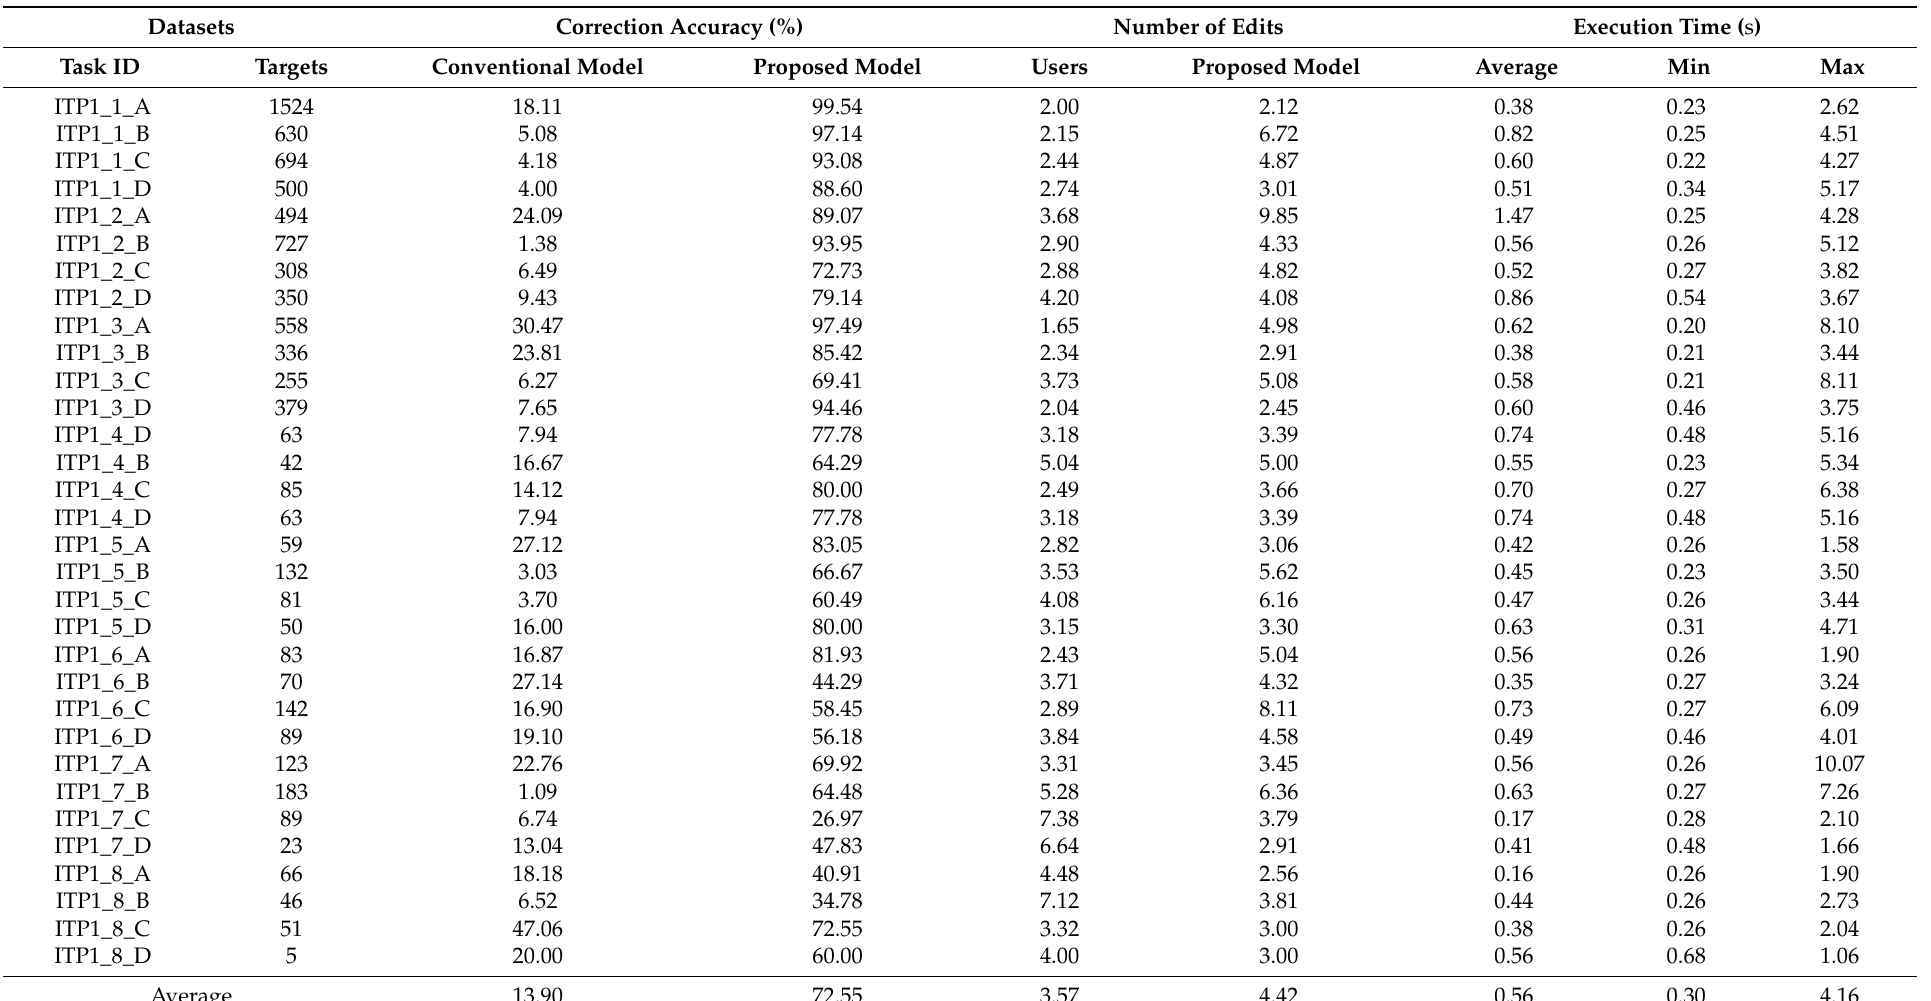
Table 6. Correction